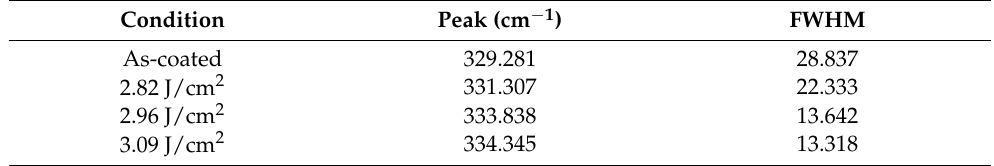
Table 2. Chemical composition and composition ratios.